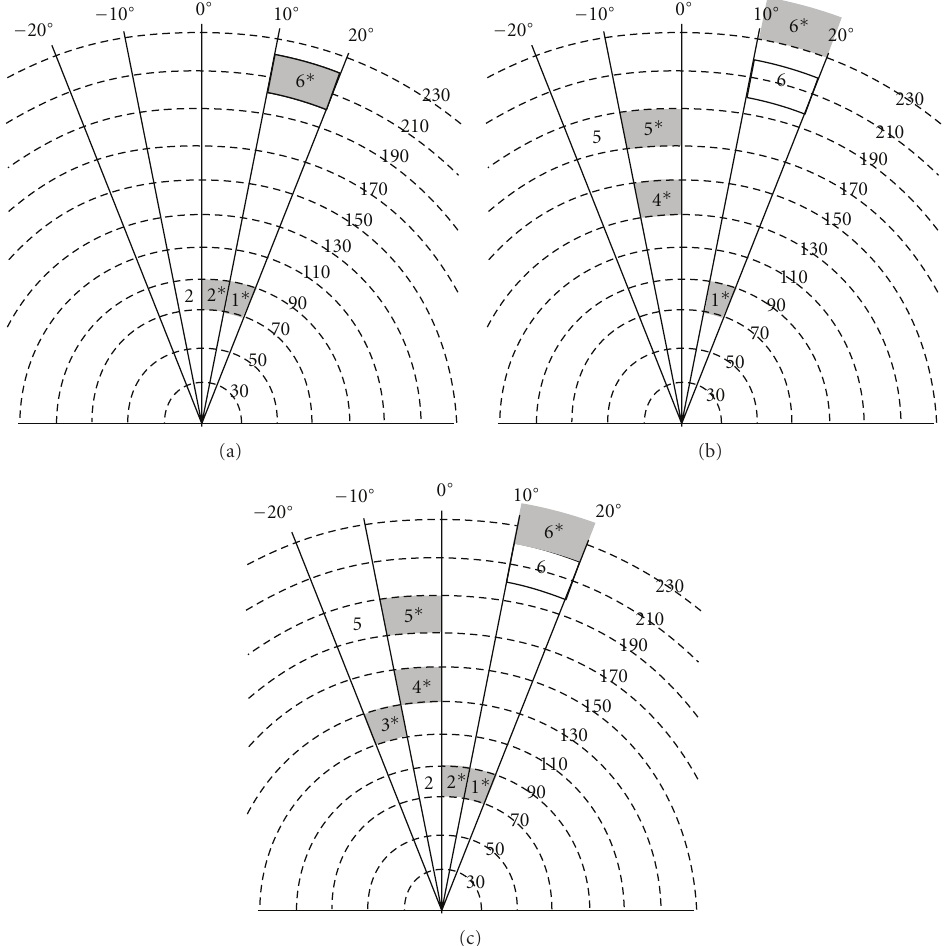
Figure 17: Estimation of distance and orientation. (a) object A , (b) object B , and (c) object C . White grids are the real positions and gray grids are the estimated